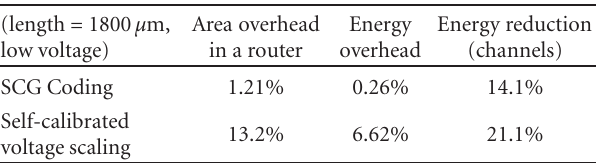
Table 3: Summaries of SCG coding and self-calibrated voltage